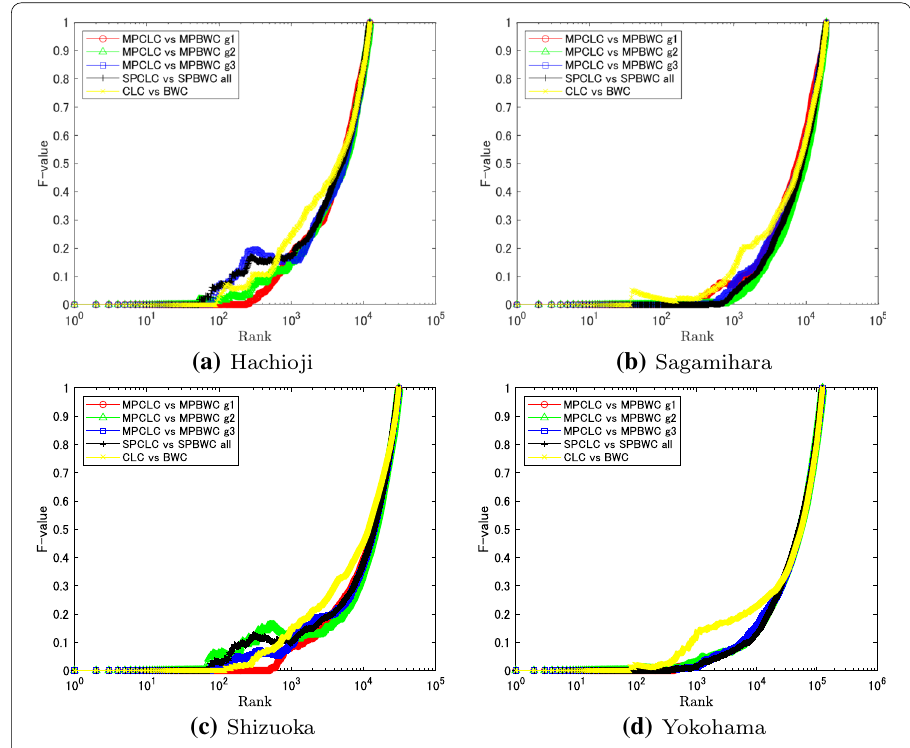
Fig. 10 Ranking-similarity between closeness based methods and betweenness based